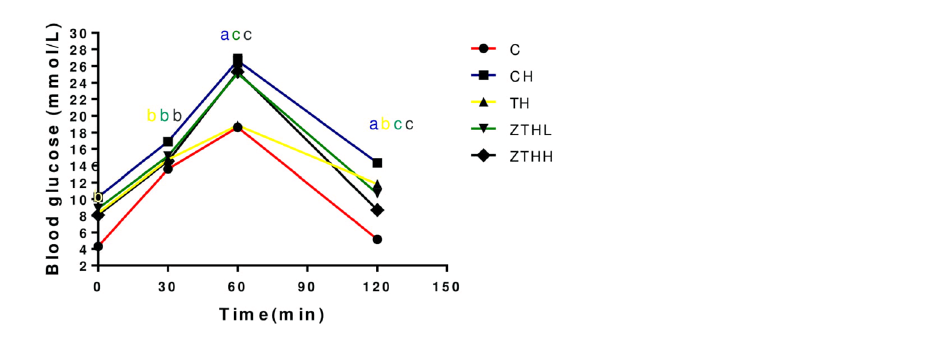
Figure 5. Effect of zinc selenium tea on OGTT in experimental groups (mean and SEM). SEM bars are small and contained within the symbol in the figure.